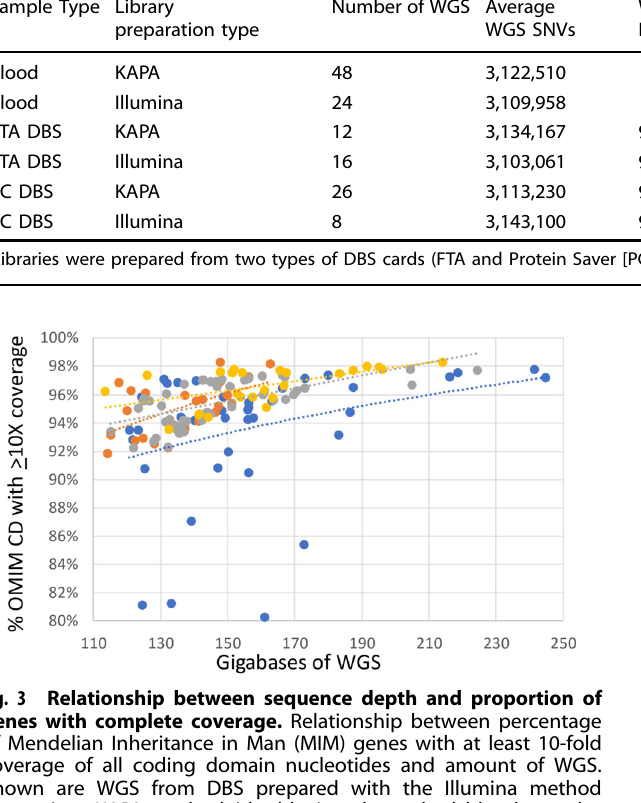
Table 3. Concordance of single nucleotide and insertion-deletion nucleotide variants (SNVs and indels) in WGS from 25 blood samples and 63 DBS derived from those samples. Sample Type Library preparation type